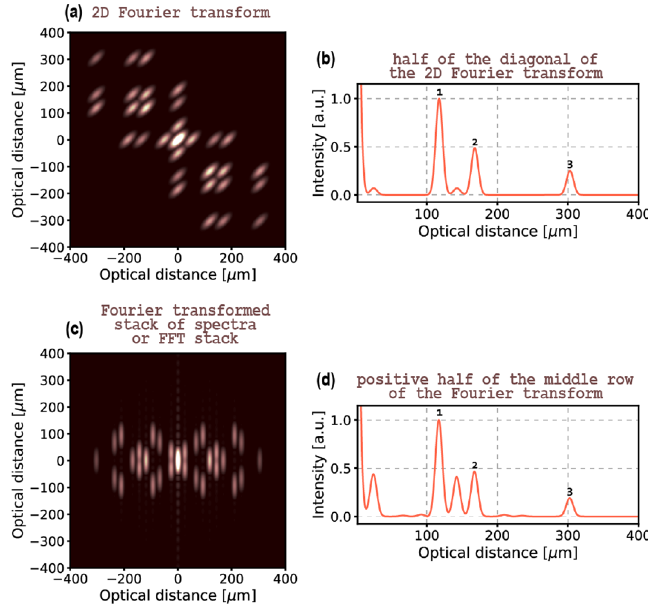
Figure 3. ( a ) 2D Fourier transformation is applied to the full joint spectrum from Fig. 1, then ( b ) its diagonal provides an A-scan where the artefacts are almost completely suppressed. ( c ) When the stack of spectra (from Fig. 1b or Fig. 2a) is 2D Fourier transformed or alternatively, when the FFT stack (from Fig. 1b) is Fourier transformed, ( d ) the middle row of the Fourier transform provides an A-scan where artefacts are reduced or completely suppressed. Note that the latter type of 2D Fourier transform approach gives a similar result as complex averaging of 50 central diagonals presented in Fig. 2. 1, 2 and 3 number the peaks representing the structure of the